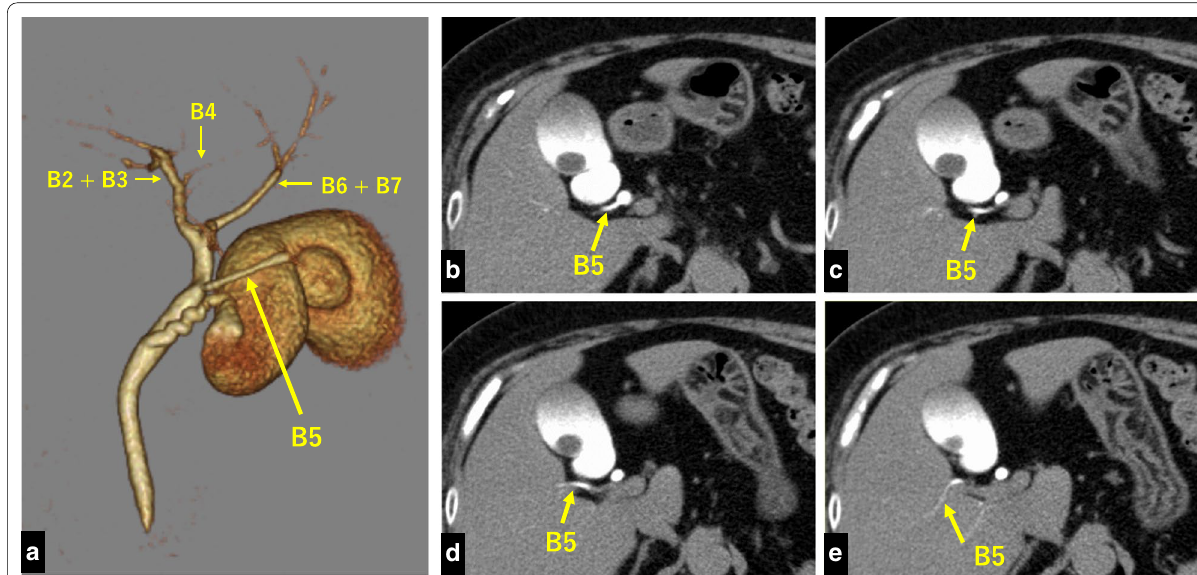
Fig. 2 A 69-year-old woman with cholelithiasis and aberrant biliary duct draining segment 5. Drip-infusion cholangiography-computed tomography accurately demonstrating the aberrant biliary duct of segment 5 branching directly off the common hepatic duct near the confluent section of the cystic duct and the common hepatic